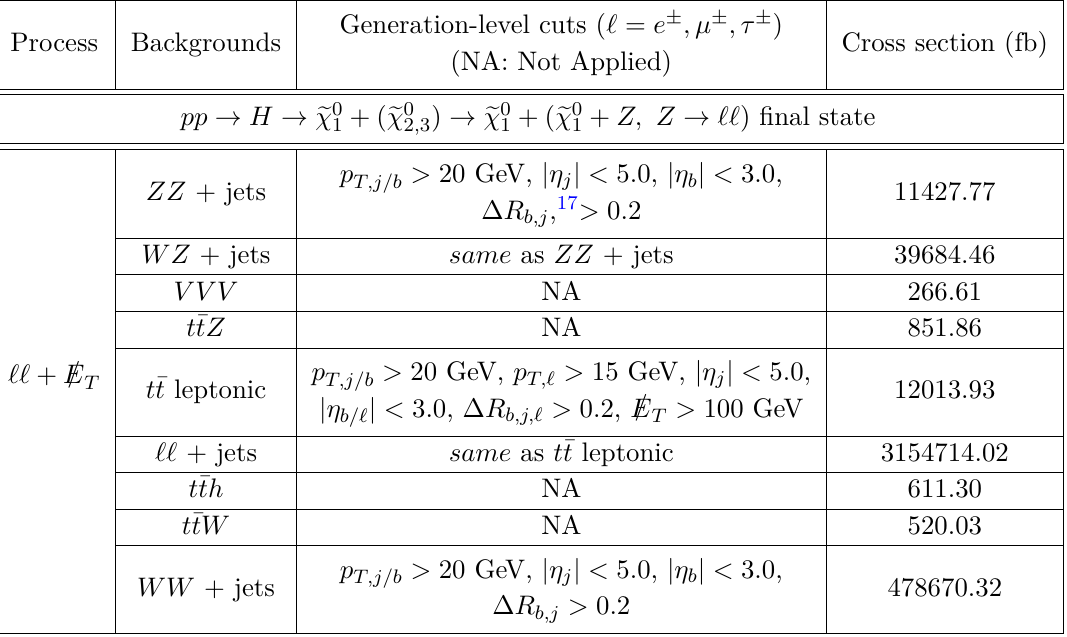
Table 36. Generation level cuts and cross-sections for the various Standard Model backgrounds used in the